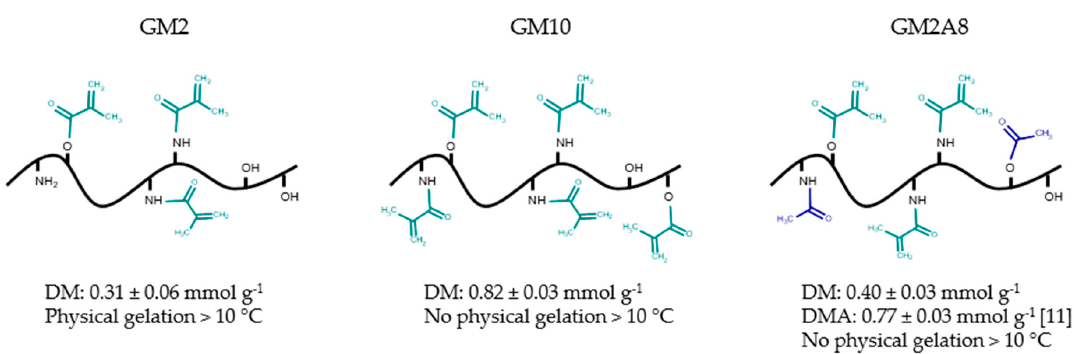
Figure 1. Schematic presentation of different gelatin derivatives used in this study. The suffix denotes the molar excess of anhydrides (MAAnh and AcAnh) used during synthesis procedure. Methacryloyl groups are marked green and acetyl groups blue. Furthermore, the degree of methacryloylation (DM), the total degree of modification (DMA, i.e., DM + degree of acetylation) and the capability to form physical gels [11] are given.